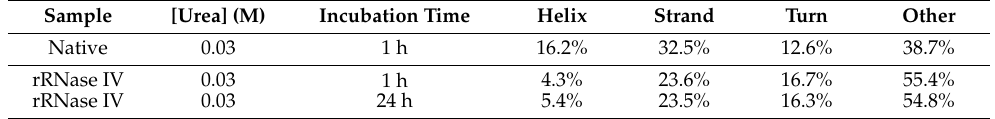
Figure 6. Analyses of rRNase IV incubated under reducing conditions at 37 ◦ C. ( A ) CD spectra of native RNase incubated in urea for 1 h without DTT (grey line), rRNase IV incubated in 0.05 M urea, 0.2 mM DTT and 1 mM EDTA for 1 h (emerald line), and rRNase IV incubated in 0.05 M urea, 0.2 mM DTT and 1 mM EDTA for 24 h (pink line). The CD spectra were recorded with a protein concentration of 1.25 µ M in 10 mM sodium phosphate buffer pH 7.4 at 25 ◦ C (see Materials and Methods). ( B ) Activity of rRNase IV incubated as in panel ( A ) and activity of native RNase (black column). All the experiments were performed as described under Materials and Methods. The error bars represent the S.D. derived from three independent experiments. Table 6. Secondary structure analysis of the CD spectra of rRNase IV.